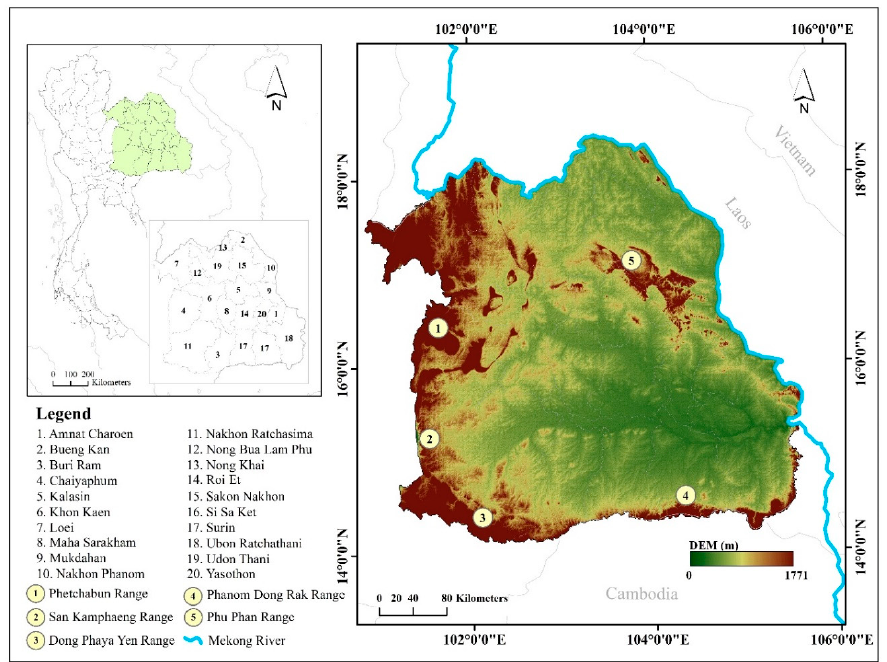
Figure 1 . Framework used to detect spatial interactions effect of population density patterns Figure 1. Framework used to detect spatial interactions e